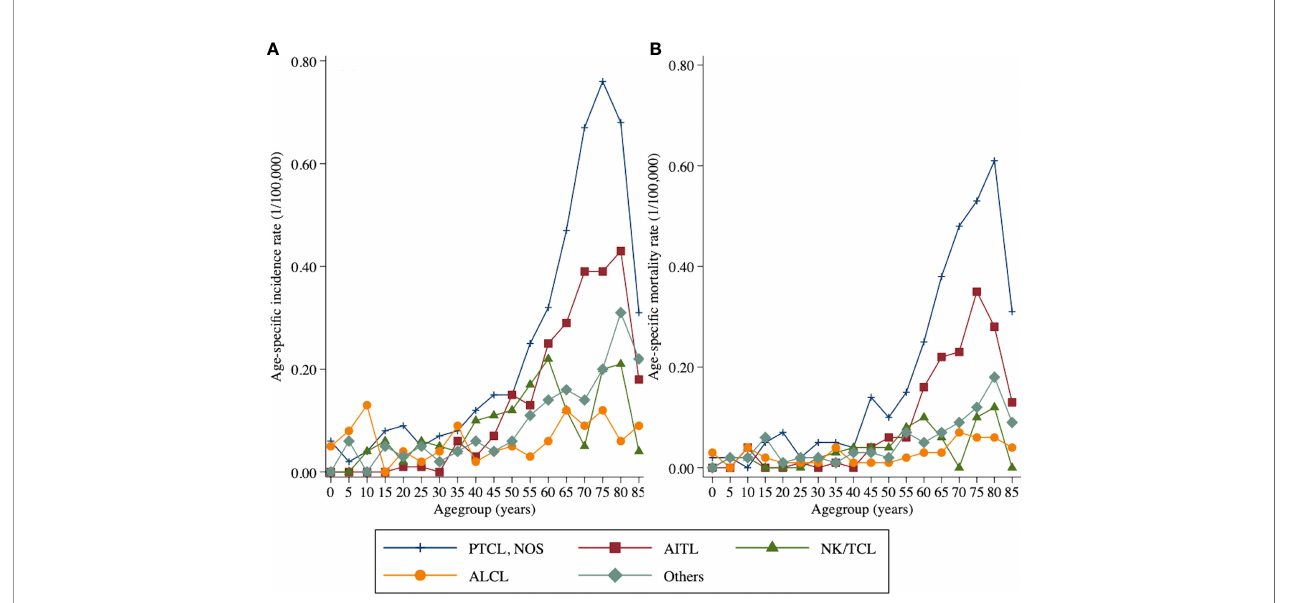
FIGURE 1 | Age-speci fi c incidence and mortality rates by histology subtype of peripheral T-cell lymphoma in Beijing from 2007 to 2018: (A) incidence and (B) mortality.